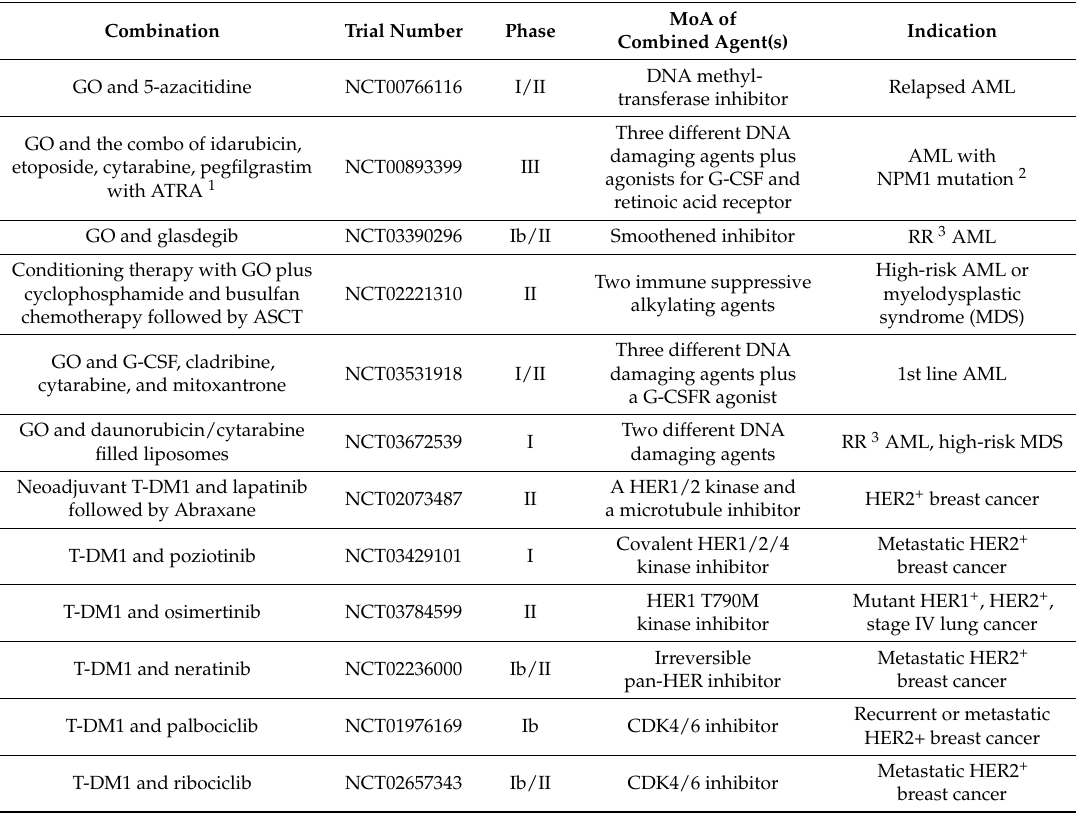
Table 2. Selected ongoing clinical trials combining antibody-drug conjugates (ADCs) with chemotherapeutics and targeted